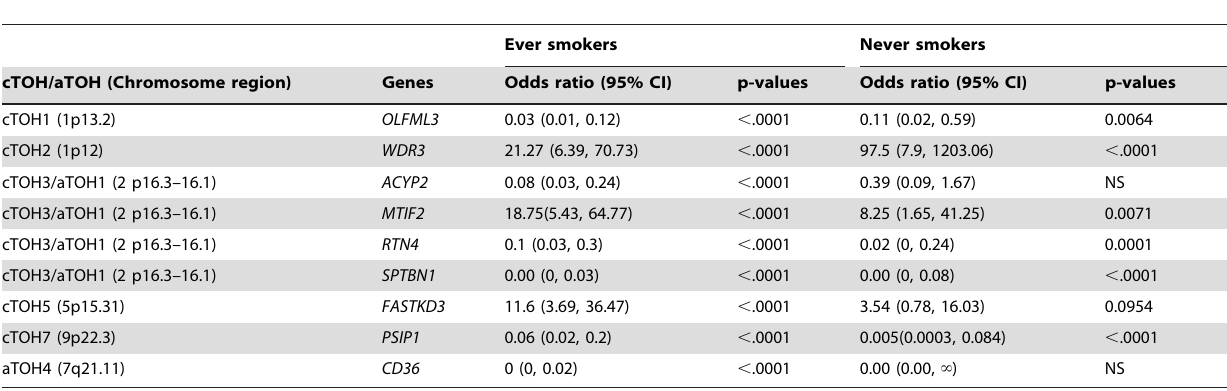
Table 3. Risk associated with differential expression of genes within aTOHs and cTOHs stratified by smoking status.